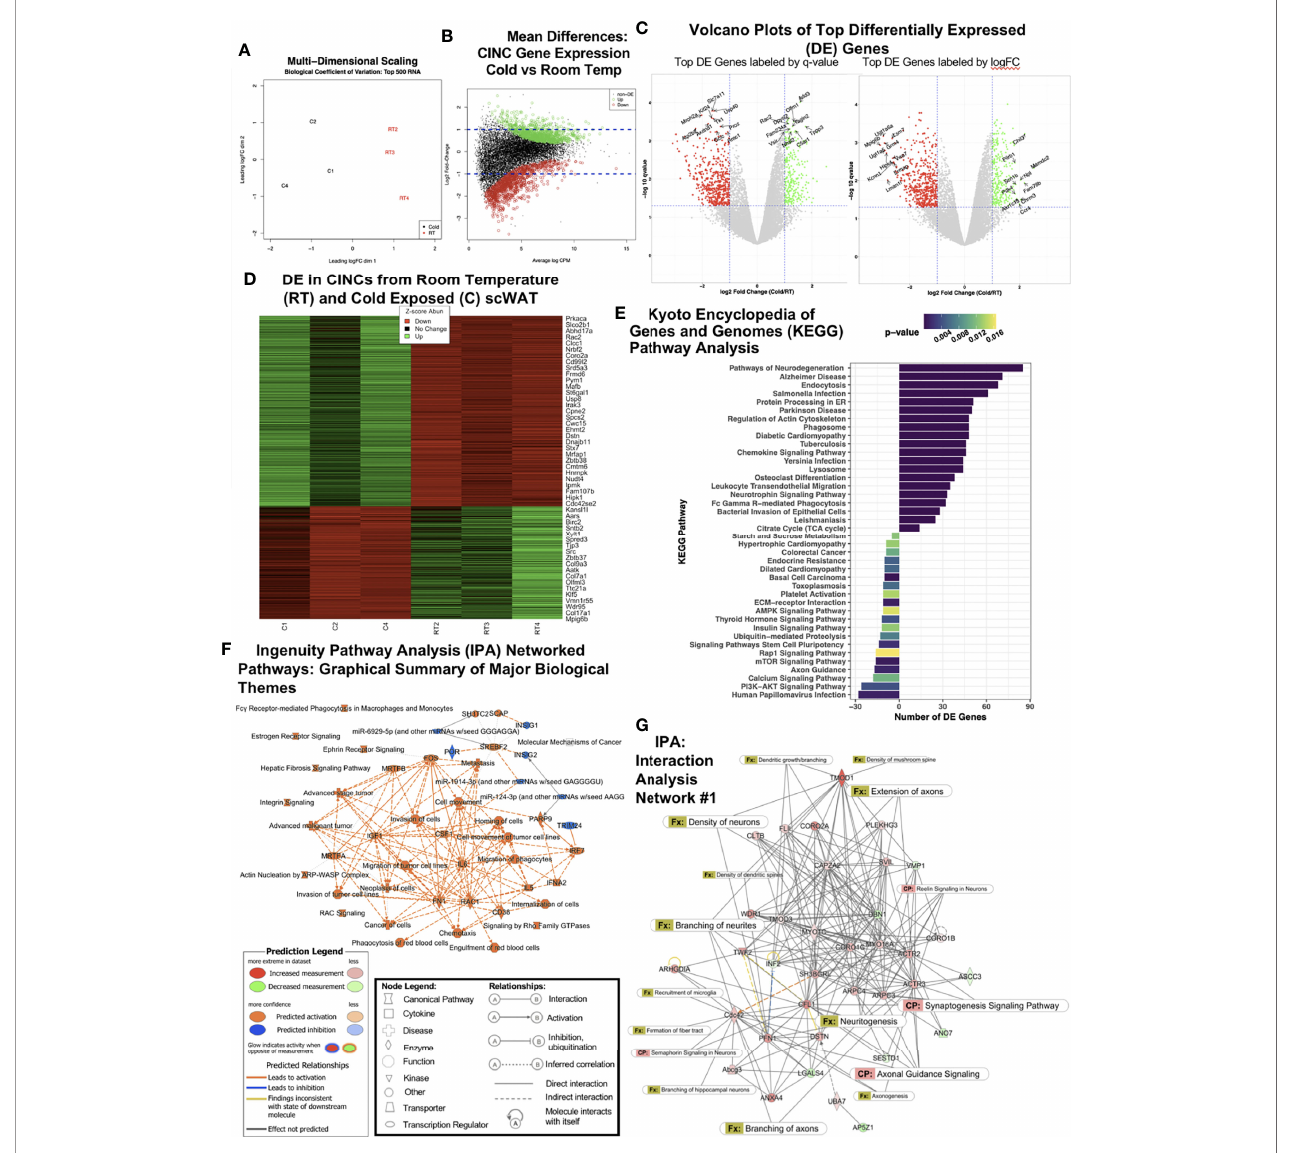
FIGURE 1 | RNAseq of cold-induced neuroimmune cells (CINCs) from room temperature (RT) versus cold-stimulated scWAT. (A) Multidimensional scaling plot depicts expression differences and clustering in the top 500 transcripts in the cold (C1, C2, and C4 in black, left) and room temperature groups (RT2, RT3, and RT4 in red, right). (B) Visualization of the log-fold-change (logFC) difference between experimental groups versus the average expression across all samples (log count per million). Genes in green and red are differentially expressed following cold or room temperature treatment, respectively, while those in black are deemed not signi fi cant ( q -value <0.05). (C) Volcano plots depict the transcriptomic pro fi les for cold-stimulated versus room temperature CINCs. Genes in green are upregulated, while genes in red are downregulated in cold-stimulated CINCs compared with room temperature CINCs and those in gray are not differentially expressed. The top 20 up- and downregulated genes are labeled by signi fi cance ( q -value, left) or by expression (logFC, right). (D) Heat map showing the gene expression pro fi le for the top up- and downregulated mRNA transcripts by Z-score. Z-score normalization was calculated across each gene (row of data). (E) Treatment-speci fi c Kyoto Encyclopedia of Genes and Genomes (KEGG) analysis. Prior to KEGG database search, the differentially expressed gene list was fi ltered for the genes upregulated in cold (bars to the right) or room temperature (bars to the left). (F) Ingenuity pathway analysis (IPA) graphical summary of major biological themes. (G) IPA generated the top gene interaction network: cellular assembly and organization, cellular function and maintenance, tissue development. canonical pathways, and functions are overlaid to show the key molecules involved in neuronal pathways and nerve function. The IPA legends correspond to Figures 1F, G